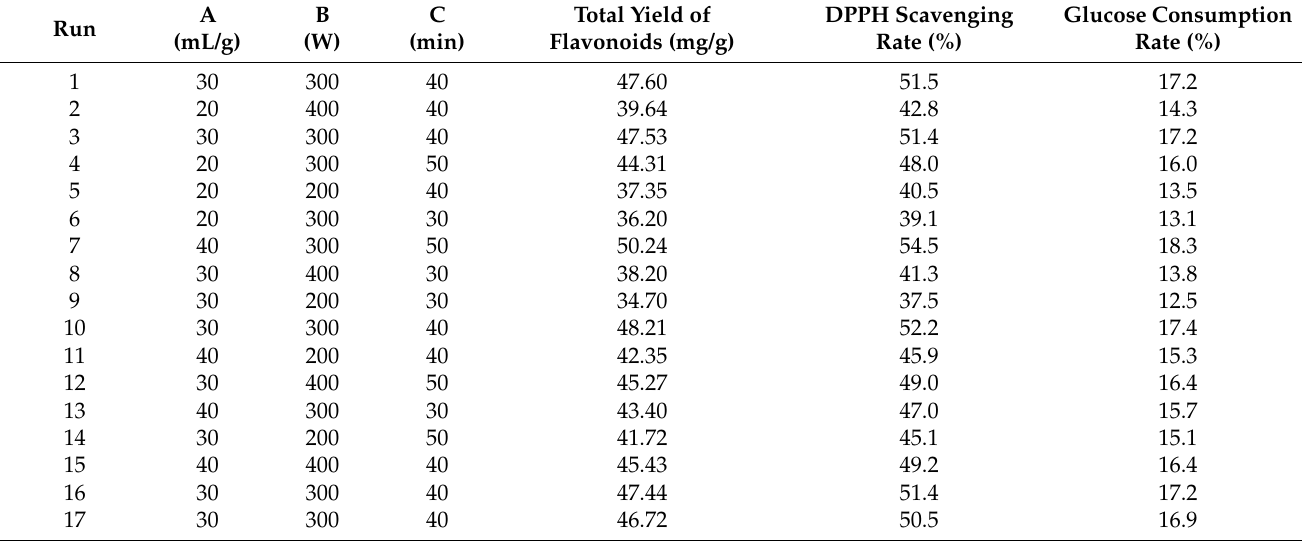
Table 2. BBD matrices with observed values for total yield of flavonoids, DPPH scavenging rate and glucose consumption rate. A: solvent/solid ratio, B: ultrasonic power, and C: extraction time. The concentration of DES-3 solution was 70 v / v